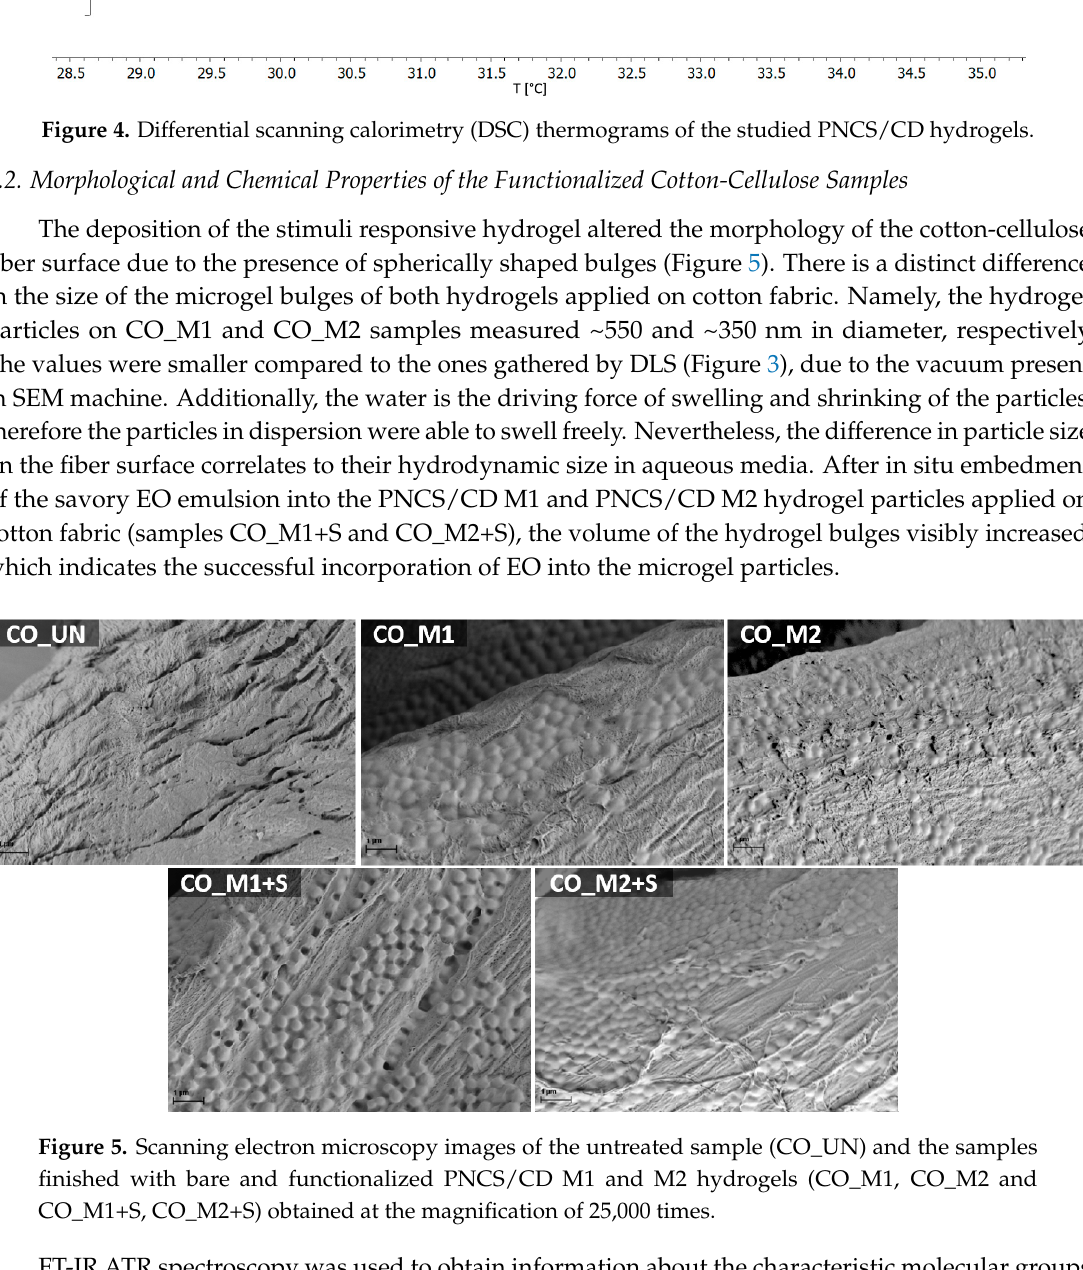
Figure 4. Differential scanning calorimetry (DSC) thermograms of the studied PNCS/CD hydrogels.